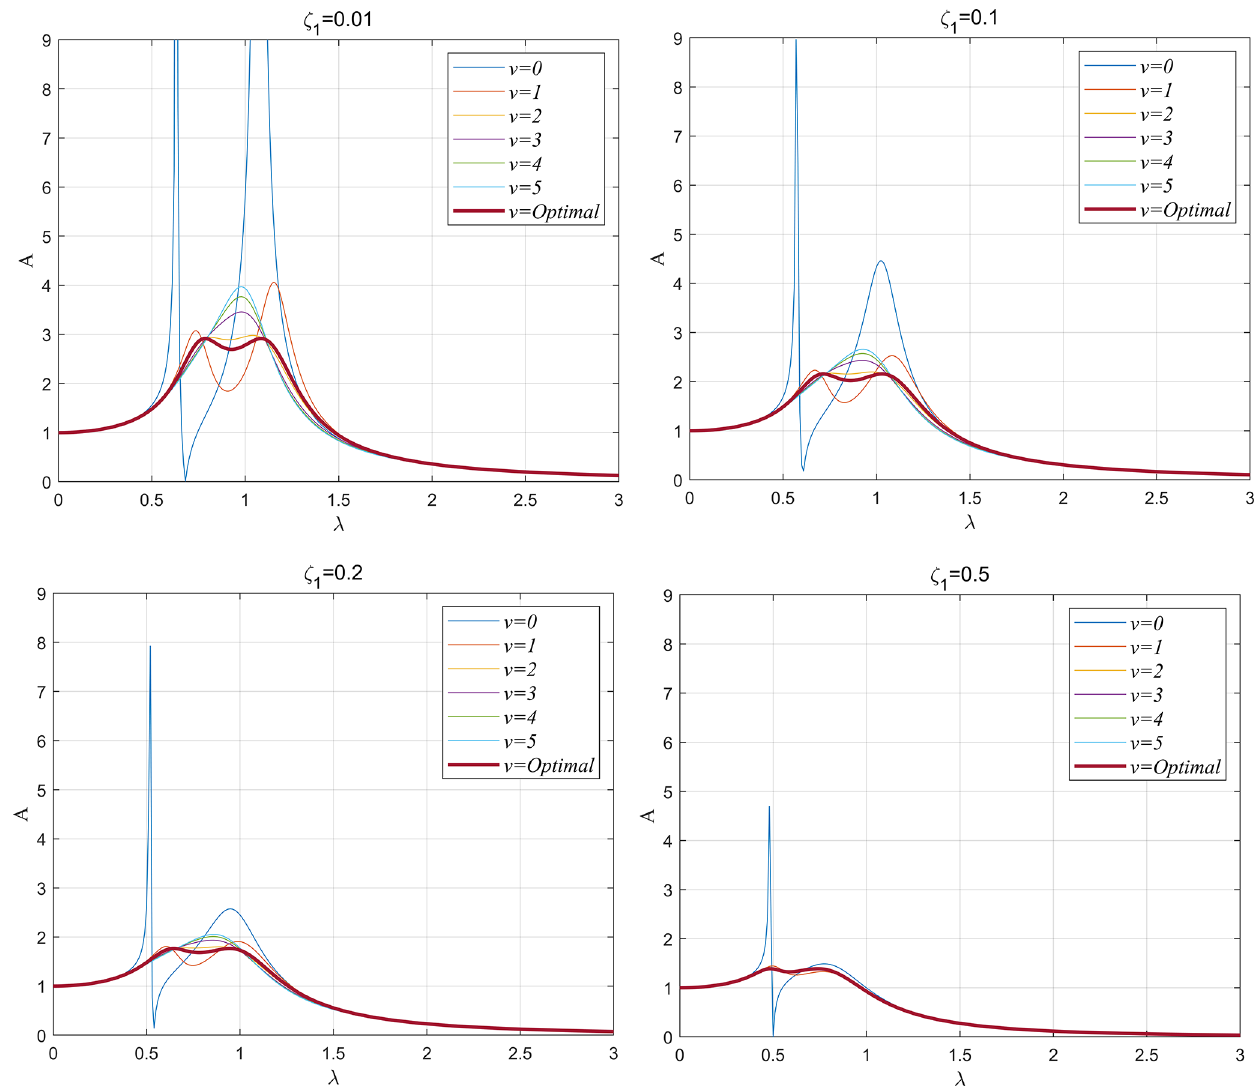
Figure 10. Normalized amplitude–frequency curves with different ζ 1 and v